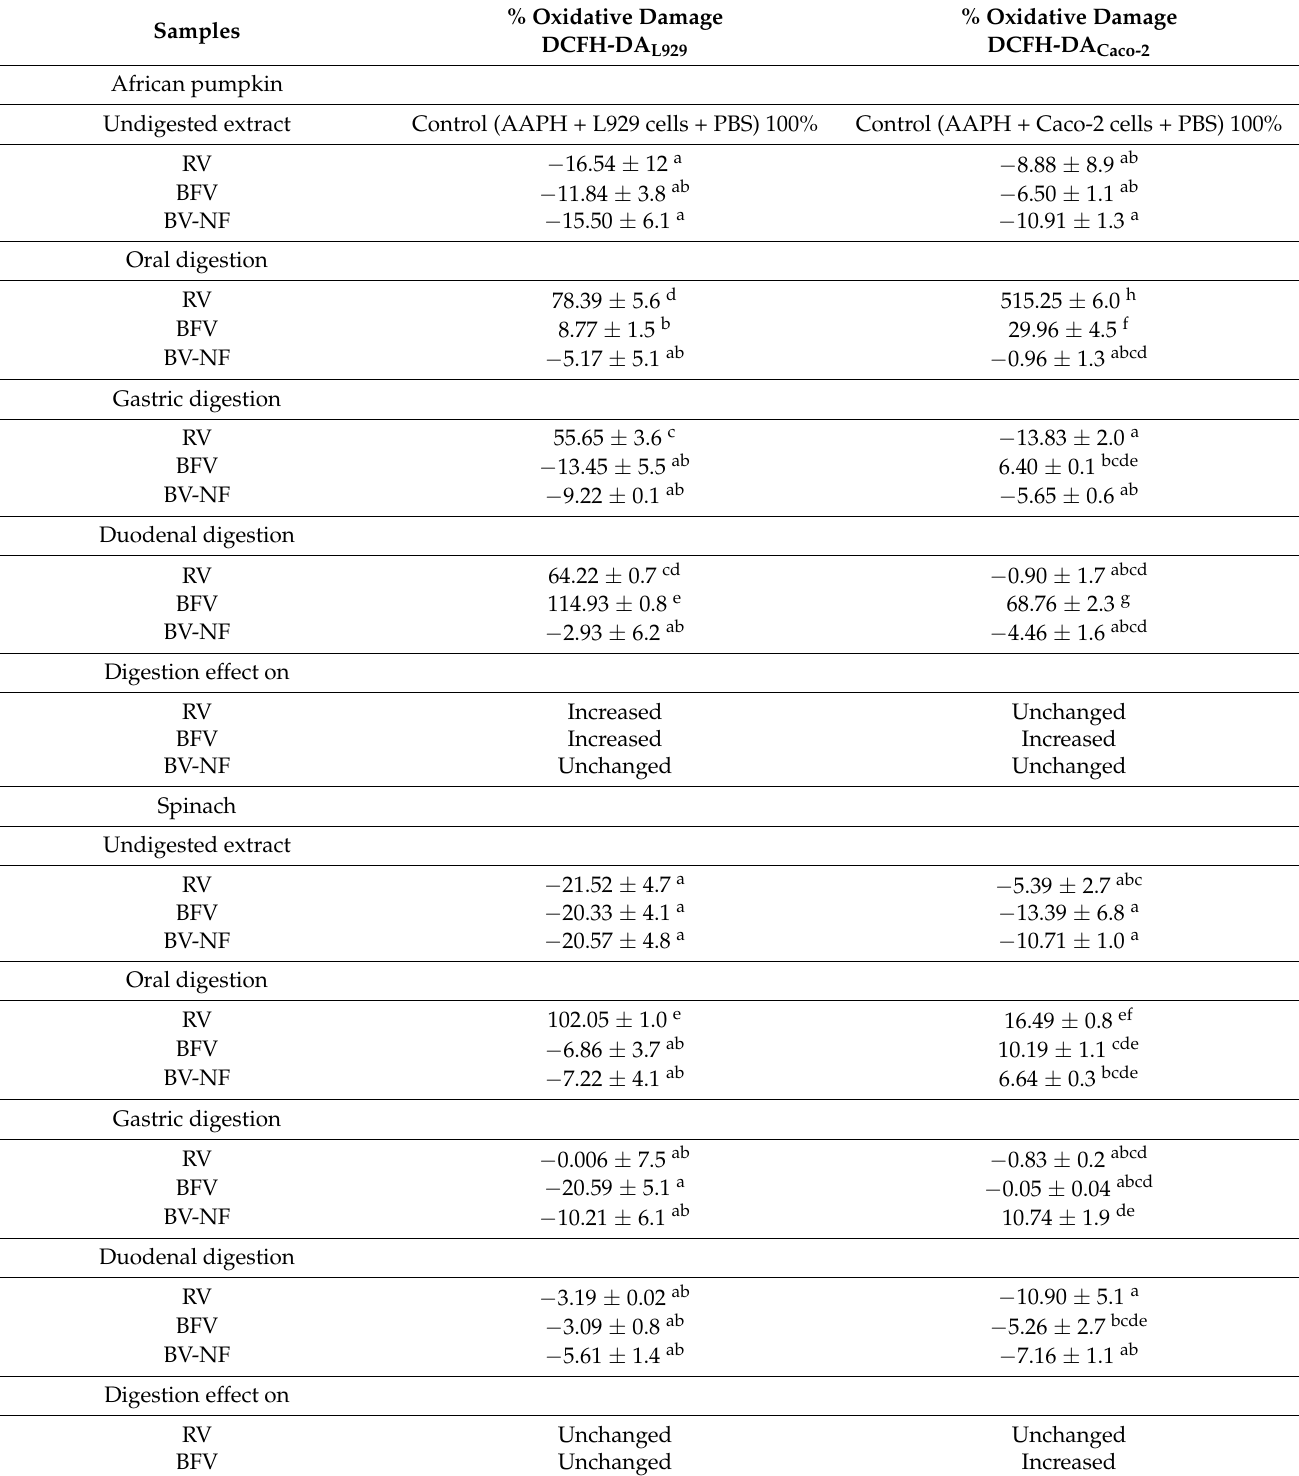
Table 4. Cellular antioxidant activity of African pumpkin and